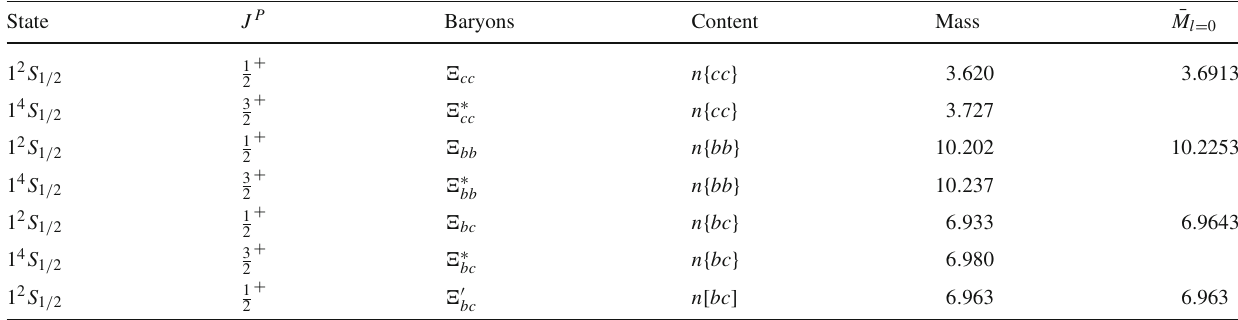
Table 2 Ground state masses (GeV) and their spin averages ¯ M l = 0 of the doubly heavy baryons in Ref. [3] State J P Baryons Content Mass ¯ M l =